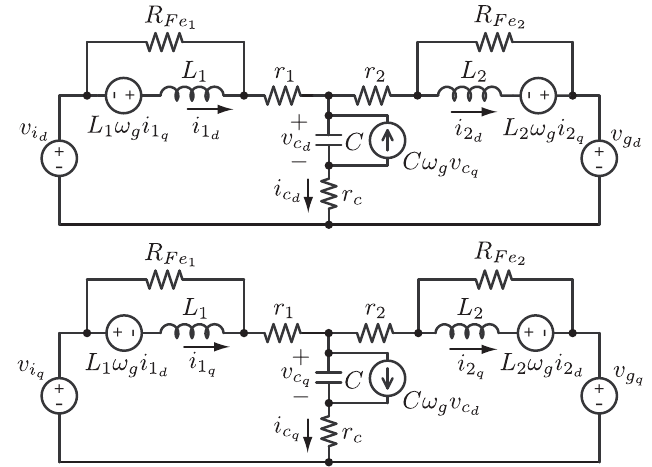
Figure 3. Model of the LCL filter in the dq reference